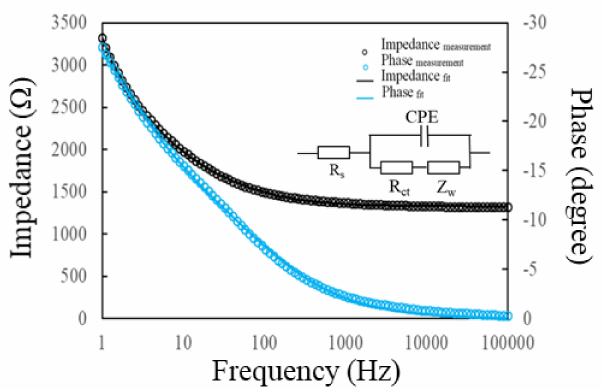
Figure 3. Modified Randles equivalent circuit diagram (inset) used to fit the impedance spectra for the PA(100):BSA(100) / MPA / AuNS / SPCEs. Black and blue circle points indicate the experimentally measured impedance and phase angle values, respectively. Black and blue lines show the corresponding fitting